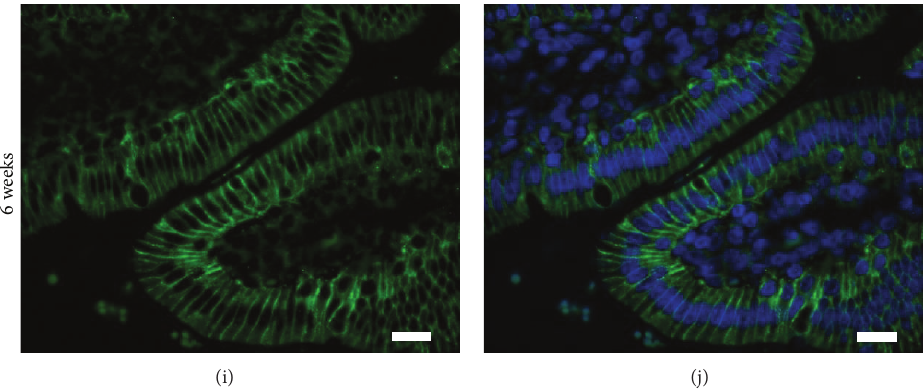
Figure 2: Claudin-4 surface localization changes over time in piglet jejunum. Claudin-4 is localized to the apical aspect of the surface of jejunal intestinal enterocytes at 24 hours of age ((a), (b)) and at 48 hours of age ((c), (d)). At 3 ((e), (f)) and 5 ((g), (h)) days of age, Claudin-4 is localized along the cellular surface between the adjacent cells and no longer at the apical aspect of the enterocytes. At 6 weeks of age, there is very strong expression at the lateral membranes between adjacent enterocytes ((i), (j)). These images are representatives of IHC performed on tissue from 3 animals per time point. Primary antibody: rabbit anti-Claudin-4. Secondary antibody: FITC-labeled goat anti-rabbit (green). Nuclear stain: DAPI